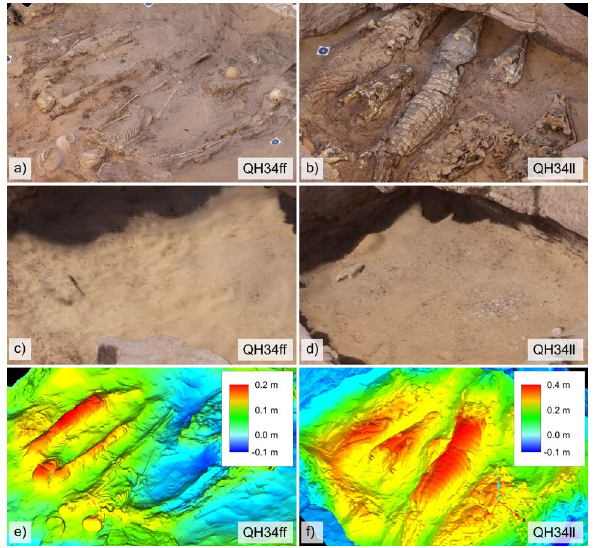
Figure 7. 3D models: a) & b) previously to the excavation; c) & d) after the excavation; e) & f) Comparison between both